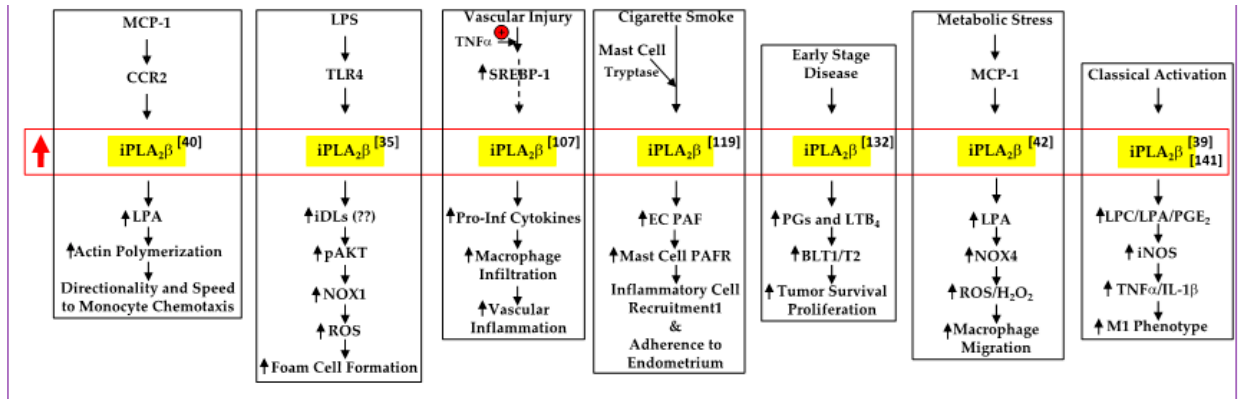
Figure 1. Proposed mechanisms by which iPLA 2 β activation contributes to monocyte chemotaxis, foam cell formation, vascular and bladder inflammation, tumor cell survival, and macrophage polarization. LPA, lysophosphatidic acid; iDLs, iPLA 2 β -derived lipids; ROS, reactive oxygen species; EC, endothelial cell ( , increased expression/activity of iPLA 2 β ; , indicates increase in).